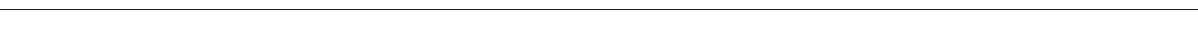
Fig. 1 Liver-speci fi c Ror α deleted mice are susceptible to diet-induced obesity. a Schematic representation of the Ror α gene-targeting strategy, including a map of the ROR α exon 4 and 5 allele ( yellow box ) and the targeting vector with loxP sites ( red arrowhead ), FRT sites ( blue box ), and puromycin selection gene ( green box ). Bg: BglII, RI: EcoRI, Bh: BamHI, Kp: KpnI, Sp: SpeI. b Southern blot analysis to screen correctly targeted Ror α + /puro ES cell clones. For BamHI digestion, the bands representing WT and mutant alleles were 9.0 kb and 6.8 kb, respectively. PCR analyses with genomic DNA extracted from tail of WT, ROR α f/+ , Alb; ROR α f/+ , ROR α f/f and Alb; ROR α f/f mice are shown. PCR were performed to amplify the cre ( top ), fl oxed and deleted allele ( bottom ). c , d mRNA expression level of ROR α in liver extract c and primary hepatocyte d from ROR α f/f and ROR α LKO mice. Expression was normalized to 18 s rRNA expression. e , f Protein expression level of ROR α in liver extract e and primary hepatocyte f . g Body weight change in ROR α f/f and ROR α LKO mice fed CD or HFD for 10 weeks ( n = 9 – 12/group). Statistical analysis was performed using Student ’ s unpaired t-test. * P < 0.05, ROR α f/f vs. ROR α LKO , HFD. h , i ROR α f/f and ROR α LKO mice were fed with HFD for 10 weeks. h Body composition analysis of ROR α f/f and ROR α LKO mice ( n = 6/group). i Macroscopic views of ROR α f/f and ROR α LKO mice. j Adipose tissues weight of ROR α f/f and ROR α LKO mice ( n = 6 – 7/group). k Representative image of epidydimal white adipose tissue (eWAT) from ROR α f/f and ROR α LKO mice stained with hematoxylin and eosin. Scale bar, 100 μ m. l , m Expression levels of in fl ammatory cytokine genes in eWAT extract l or thermogenesis genes in BAT extract m from ROR α f/f and ROR α LKO mice ( n = 4 – 5 per group) as determined by qRT-PCR. Expression was normalized to L32 expression. n Metabolic cage studies were performed in ROR α f/f and ROR α LKO mice ( n = 5 – 6 mice/group). O 2 consumption (VO 2 ), CO 2 production (VCO 2 ) and energy expenditure were represented ( left to right ). Statistical analysis was performed using Student ’